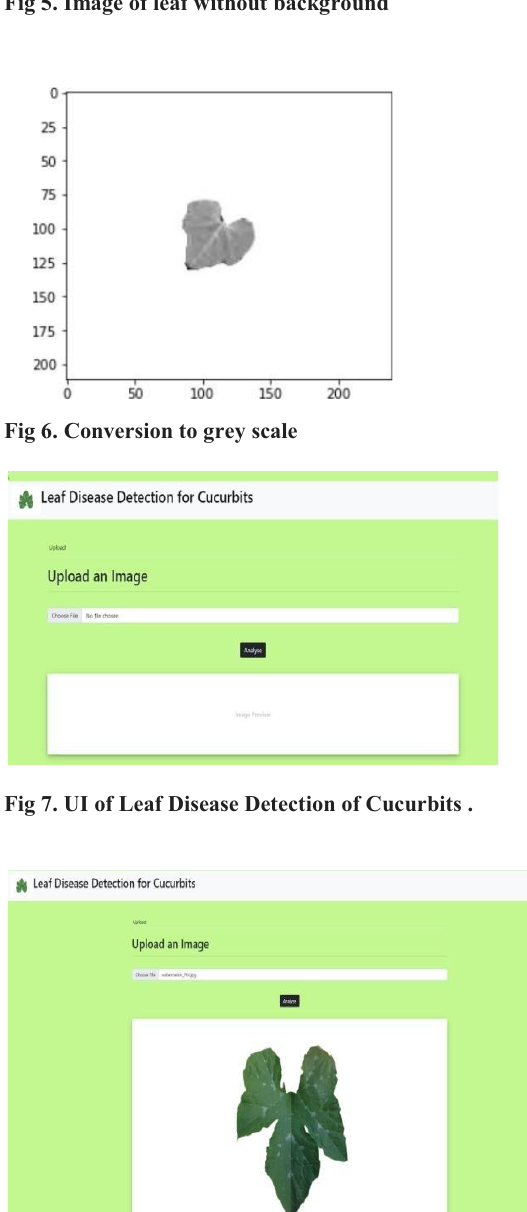
Fig 9. Displaying the result after analysis (Diseased)